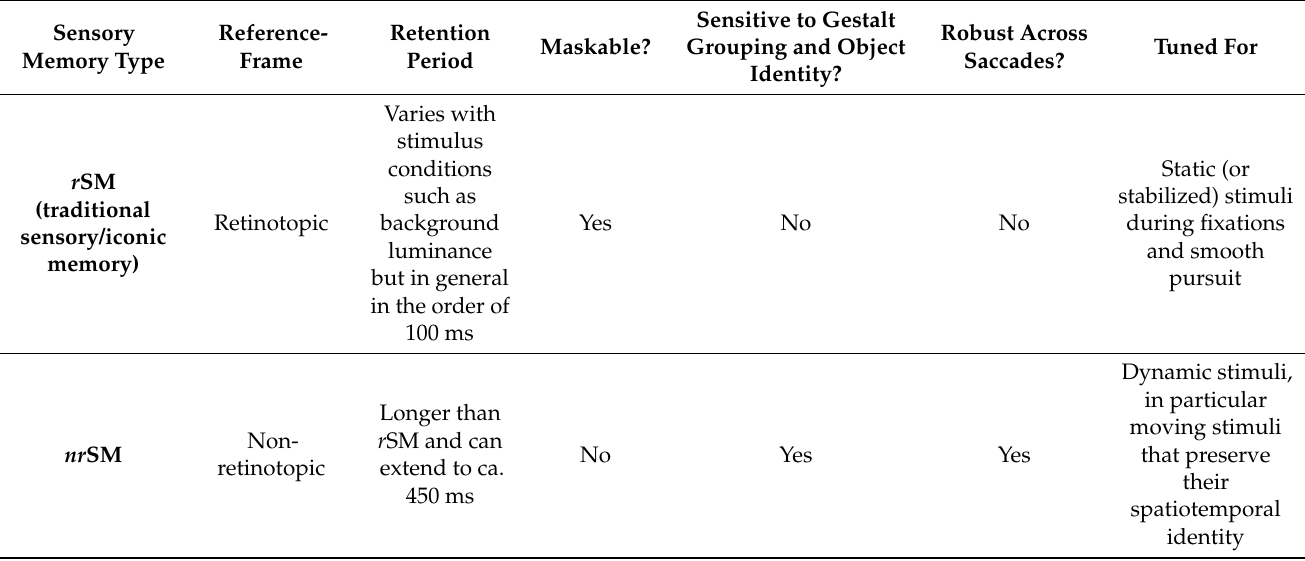
Table 1. Comparison of retinotopic and non-retinotopic sensory